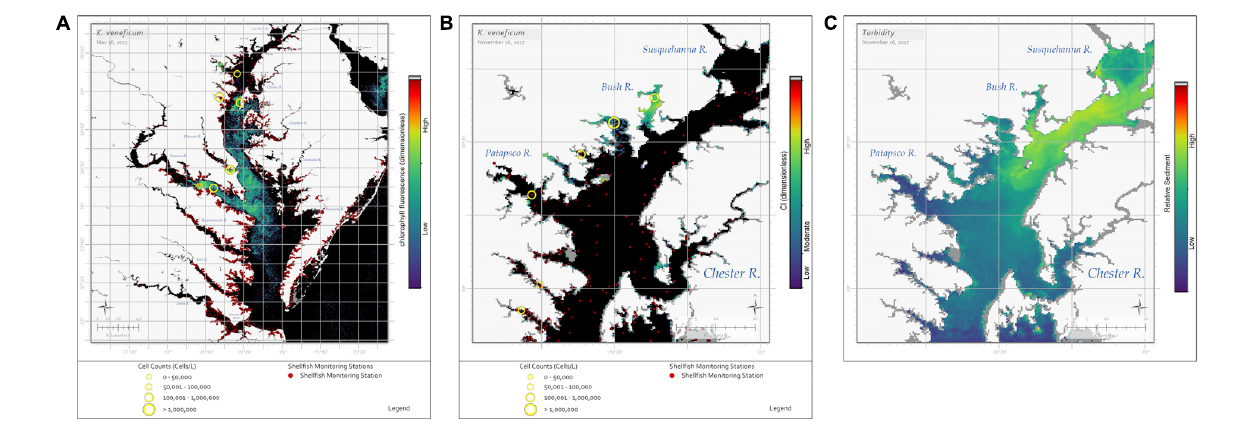
FIGURE 3 | Sentinel-3a OLCI images showing blooms of the dinoflagellate K. veneficum. (A) The RBD algorithm captured a bloom on May 16, 2017 throughout the Maryland portion of the Chesapeake Bay. Yellow circles indicate in situ cell concentrations determined using light microscopy for water samples collected on the same day, with symbol size representing cell concentration ranges. (B) The CI algorithm captured a bloom on November 16, 2017 in the Bush River, Maryland. Yellow circles indicate in situ cell concentrations determined using light microscopy for water samples collected November 13–16, 2017, with symbol size representing cell concentration ranges. K. veneficum cells in the Bush River bloom were documented to be actively feeding on cryptophyte prey. (C) The R rs (665 nm) image from November 16, 2017 shows a sediment plume from the Susquehanna River, with warmer colors indicating higher sediment concentrations. Black pixels indicate no bloom detected. The dark red dots on (A,B) indicate shellfish growing area classification